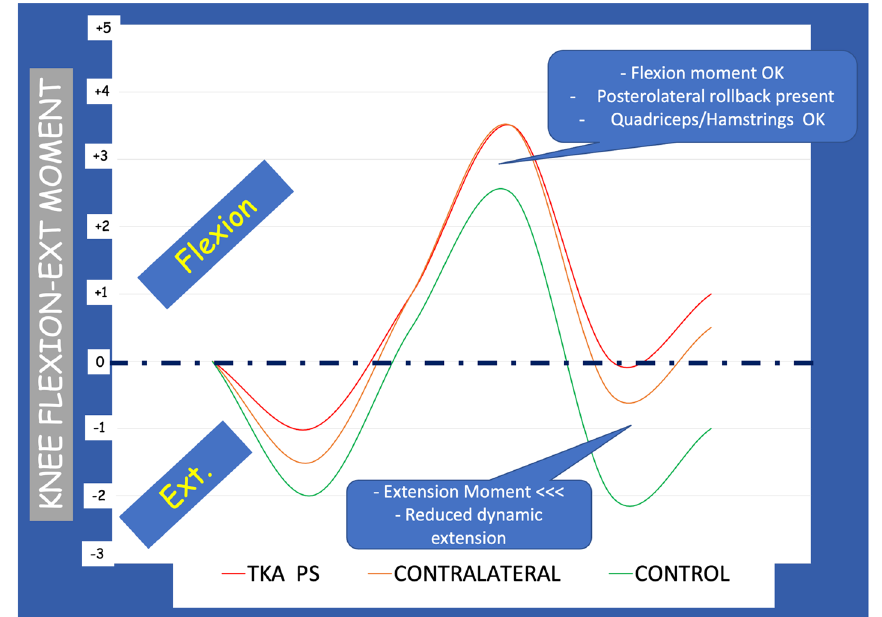
Fig. 3 Analysis of the knee flexion–extension moments during gait. The bi-cruciate substituting PS TKA group had less late stance peak extension moments compared to healthy